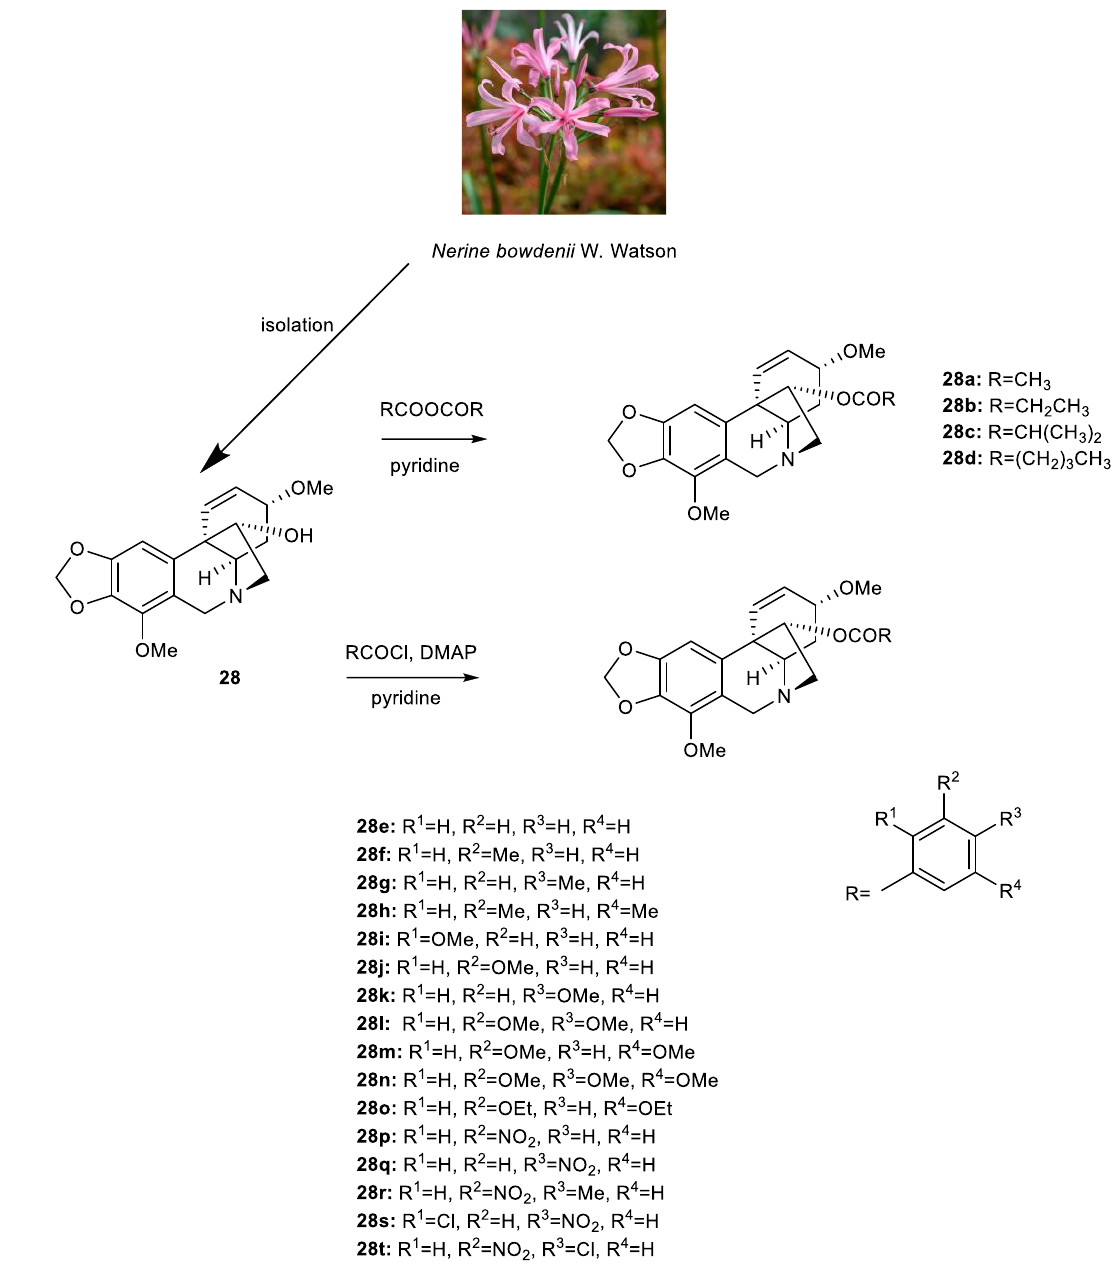
Figure 2 . Synthesis of aliphatic ( 28a–d ) and aromatic ( 28e–t ) esters of ambelline . Figure 2. Synthesis of aliphatic ( 28a–d ) and aromatic ( 28e–t ) esters of